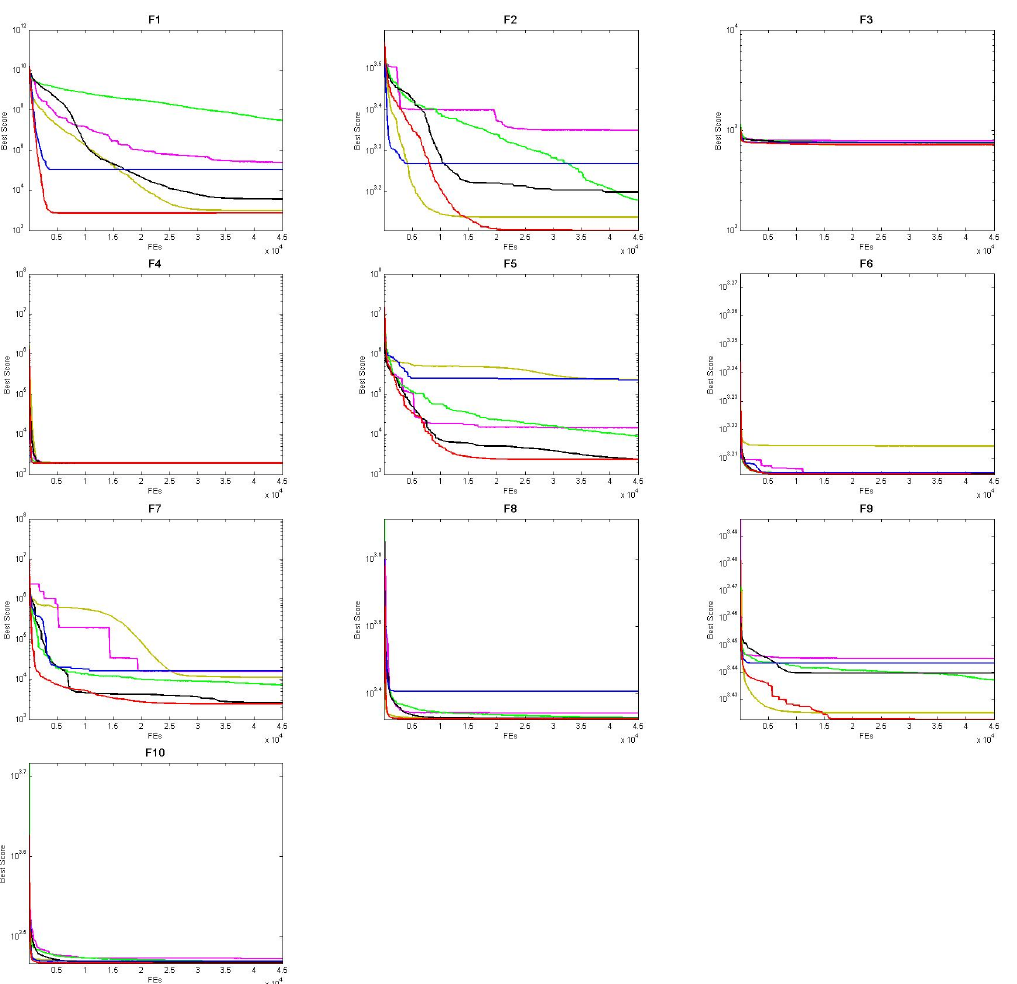
Figure 2. Convergence plots of the new mHGS and the addressed optimizers for the CEC’2020 benchmarks where the dimension is 10.